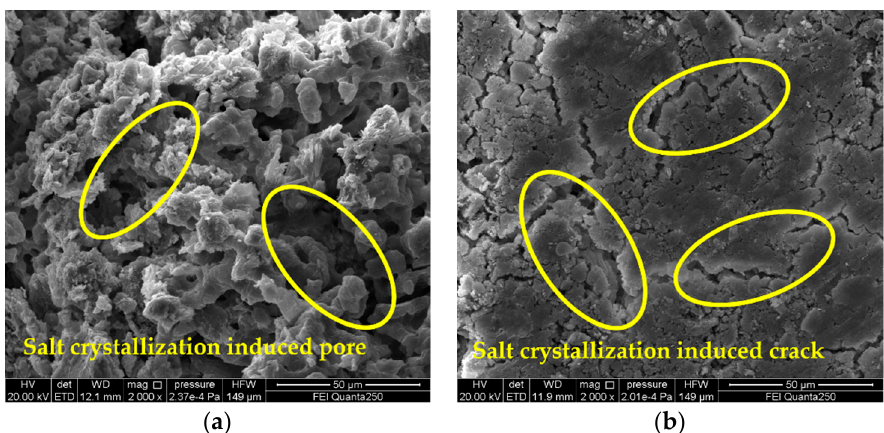
Figure 6. SEM image of gray brick sample of 5% magnesium sulfate (A 3 B 3 C 2 ) cycled 20 times. Detail of microcracks induced by crystallization of magnesium sulfate salt (yellow circle). ( a ) inside the sample; ( b ) the surface of the sample.